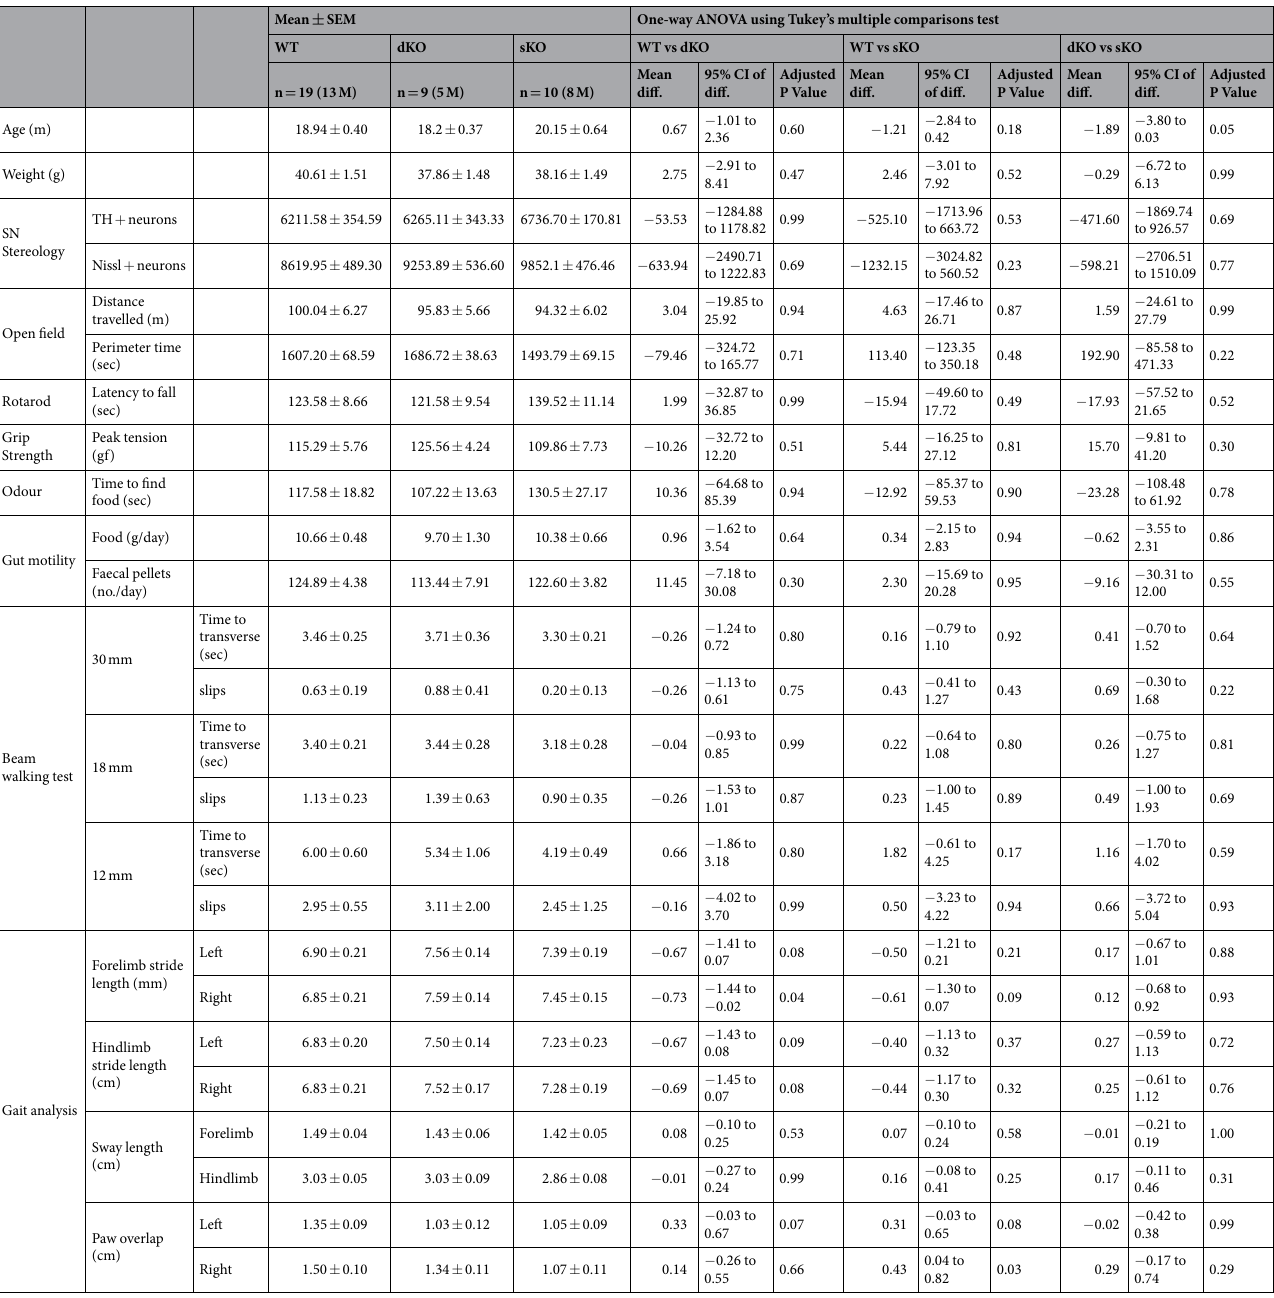
Table 1. Neuropathological and behavioural features of the knockout